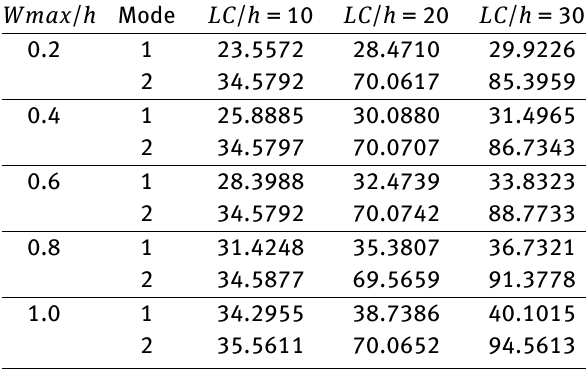
Table 6: Effect of amplitude ratio, frequency mode and curvature to thickness ratio on dimensionless mean nonlinear natural frequency with [P/0 ∘ /90 ∘ /90 ∘ /0 ∘ ] conical shell